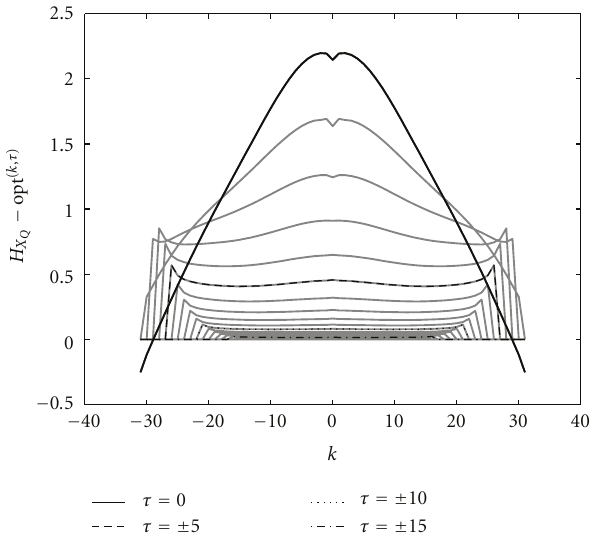
Figure 3: The MSE optimal kernel function for the family of nonstationary AR(1)-processes.